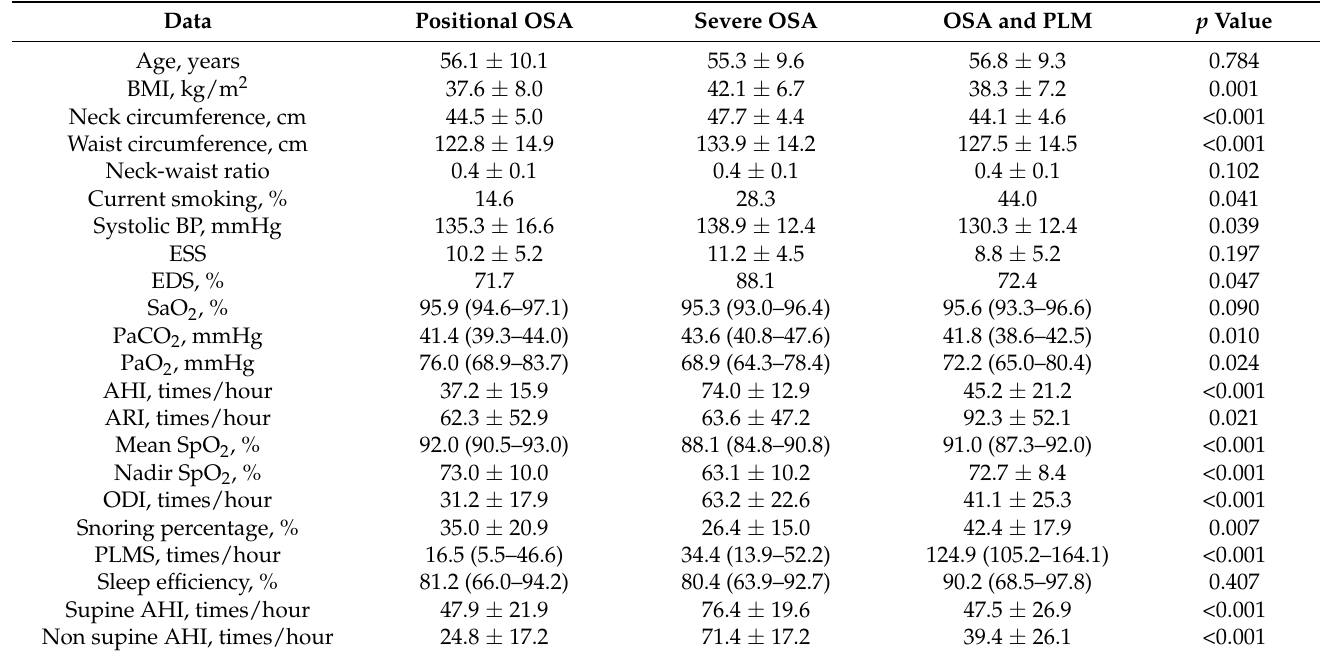
Table 3. Clusters and their